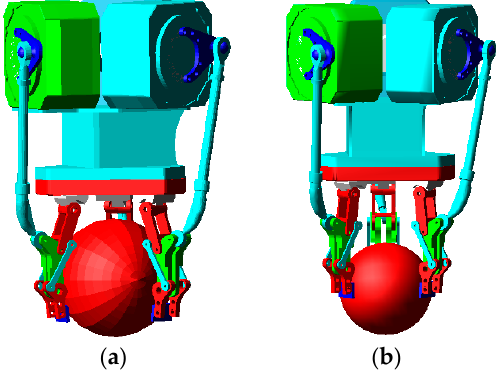
Figure 9. Simulation process of the gripper grabbing a sphere. ( a ) Grasping the ball. ( b ) Pinching the ball.